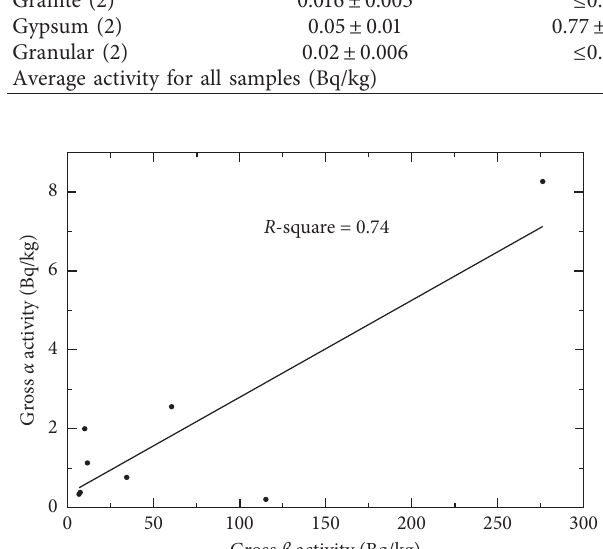
Figure 1: Correlation between gross alpha and beta activities.